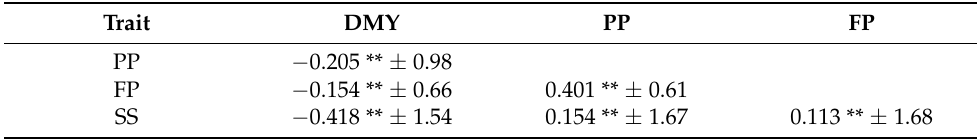
Table 4. The relationships of DMY with PP and FP were negative, which corresponds to the well-known dilution effect reflecting the reductions in fat and protein contents as milk yield increases [37]. Among milk components and SCC, positive correlations were found. Some authors found a negative and significant phenotypic correlation between the logarithm of somatic cell count and milk yield [38]. Milk protein content consistently showed a significant positive correlation to the logarithm of SCC. Their study showed a similar correlation between SCC and milk yield, or milk protein content of dairy goats’ milk as found in dairy cows’ milk. However, they stated the impossibility of employing commonly used physiological parameters for dairy cows in evaluating the mammary health status of dairy goats. According to other results, the goat milk composition did not change when milk SCC varied among three groups from 214,000 to 1450,000 cells/mL [39]. In ovine milk, the components can be expected to vary independently of milk SCC [40]. Table 4. Pearson correlation coefficients between all analysed traits.